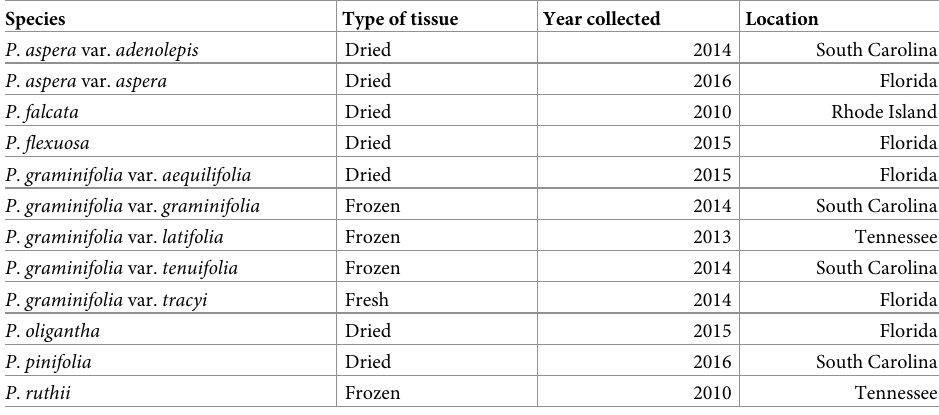
Table 1. State of tissue after collection, date, and location of Pityopsis individuals.